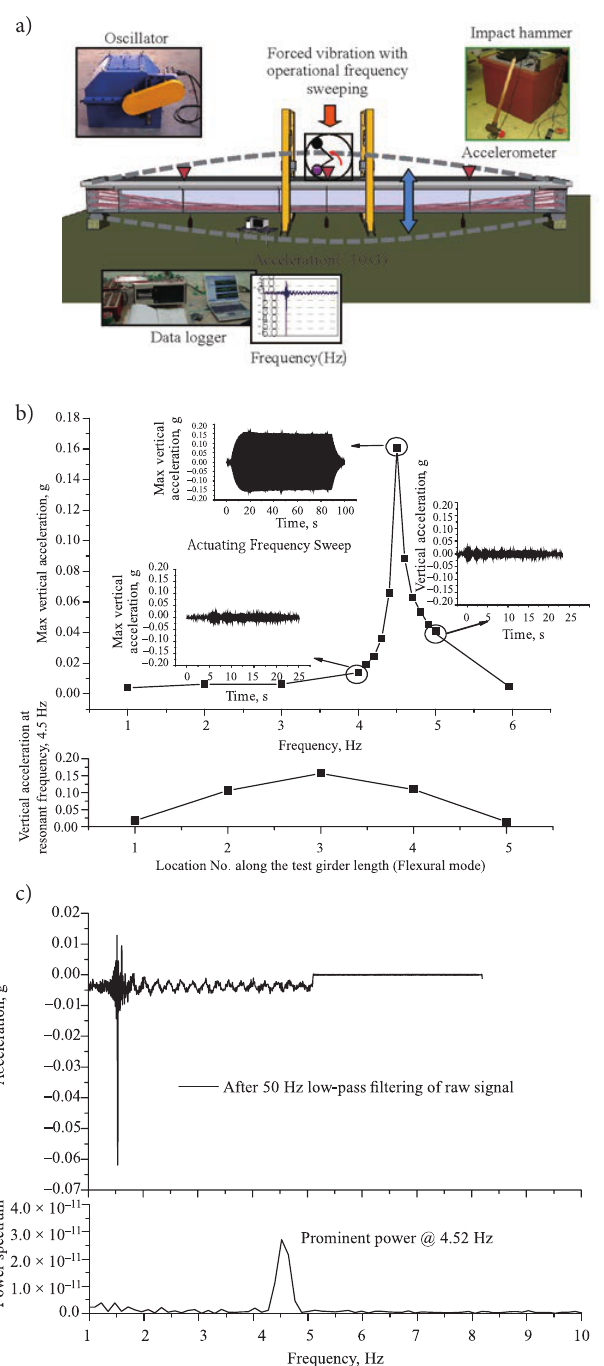
Fig. 3. Measurement of natural frequency and damping ratio: a – forced vibration test with inertial oscillator/impact hammer; b – natural frequency extraction (by oscillator); c – natural frequency extraction (by impact